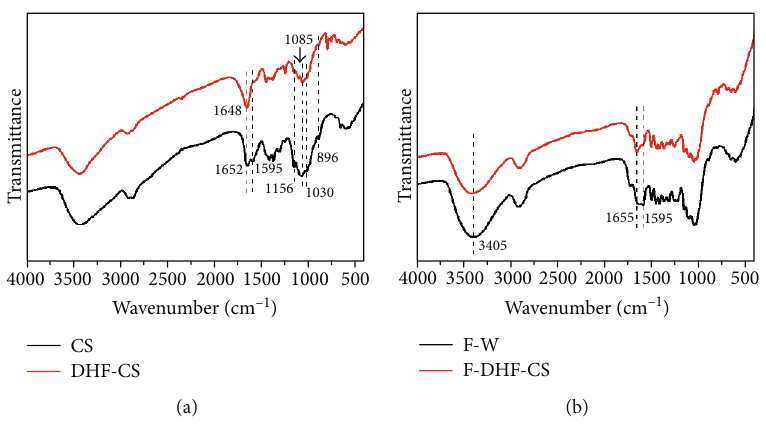
Figure 3: FTIR spectra of (a) CS and DHF cross-linked CS, (b) F-W, and F-DHF-CS.